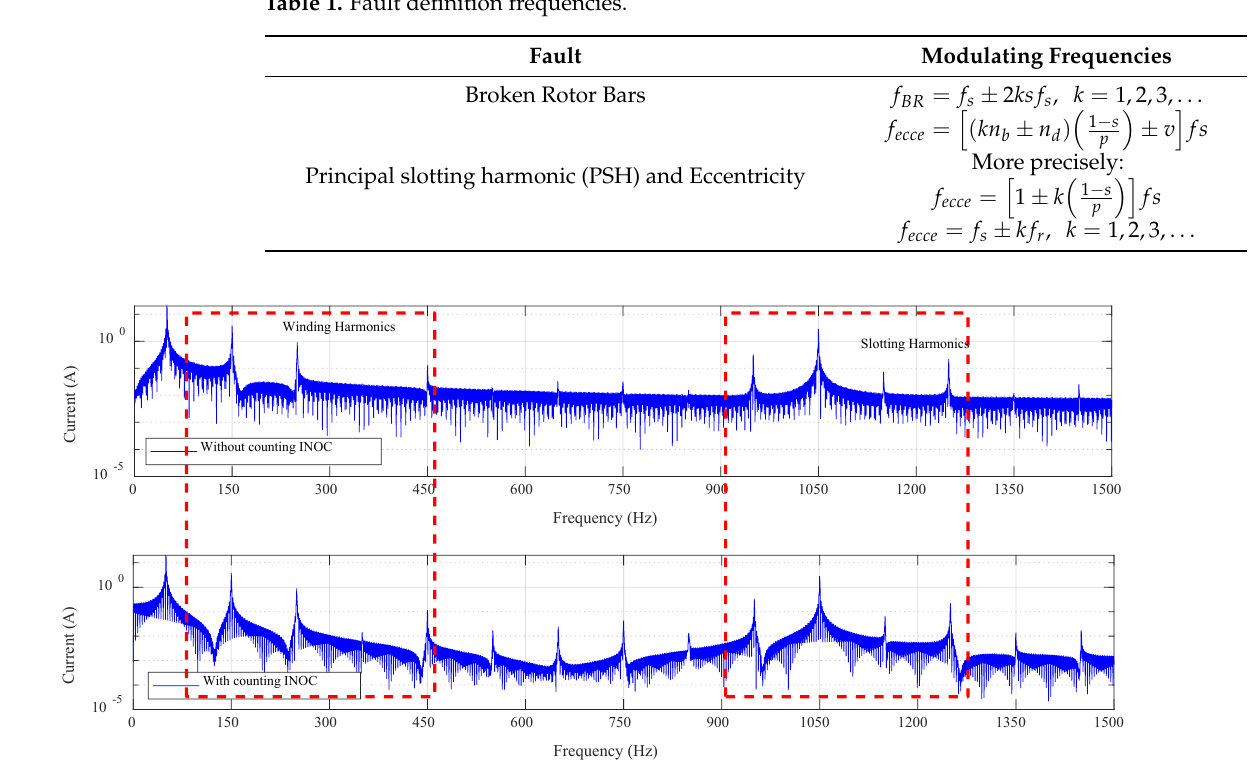
Figure 9. The simulated stator current spectrum showing stator winding and slotting harmonics before and after counting integral number of cycles (INOC).